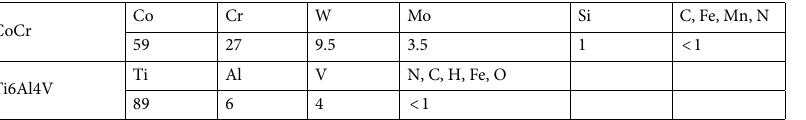
Table 1. Chemical composition of the as-received dental CoCr and Ti6Al4V powders; all results in